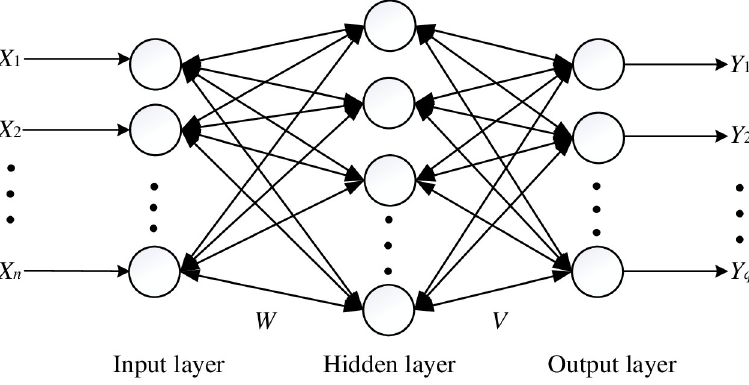
Fig 2. Logical structure of an early warning model algorithm based on a single hidden-layer BP neural network.